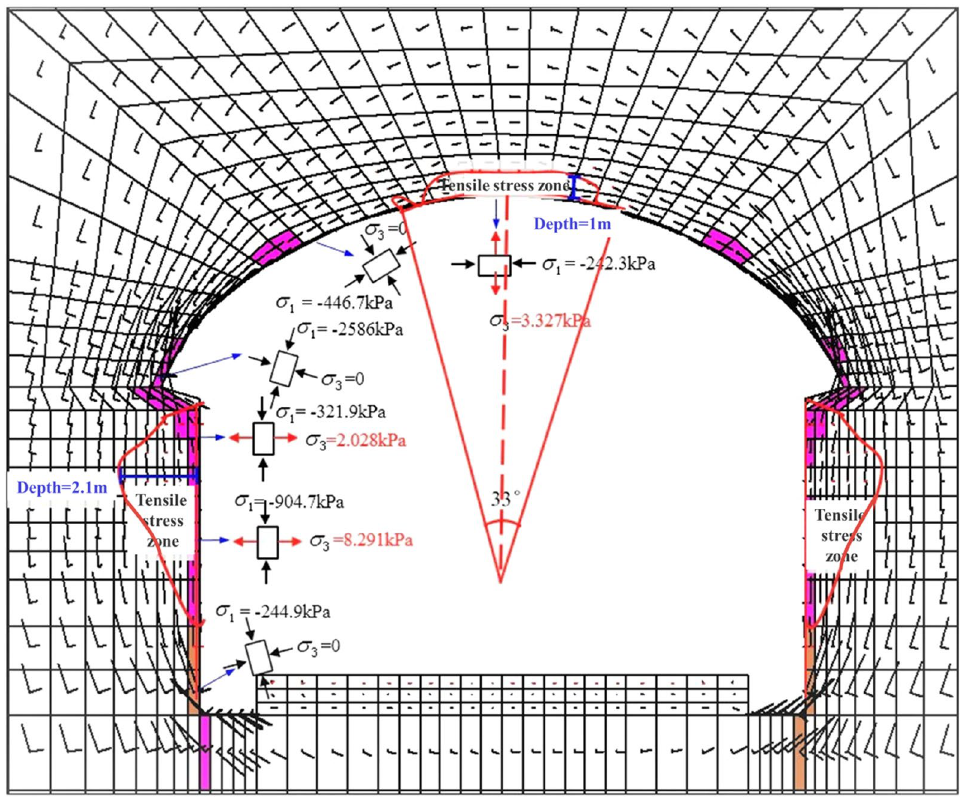
Figure 14. Principal stress vector diagram of an unsupported grade-IV1 tunnel.